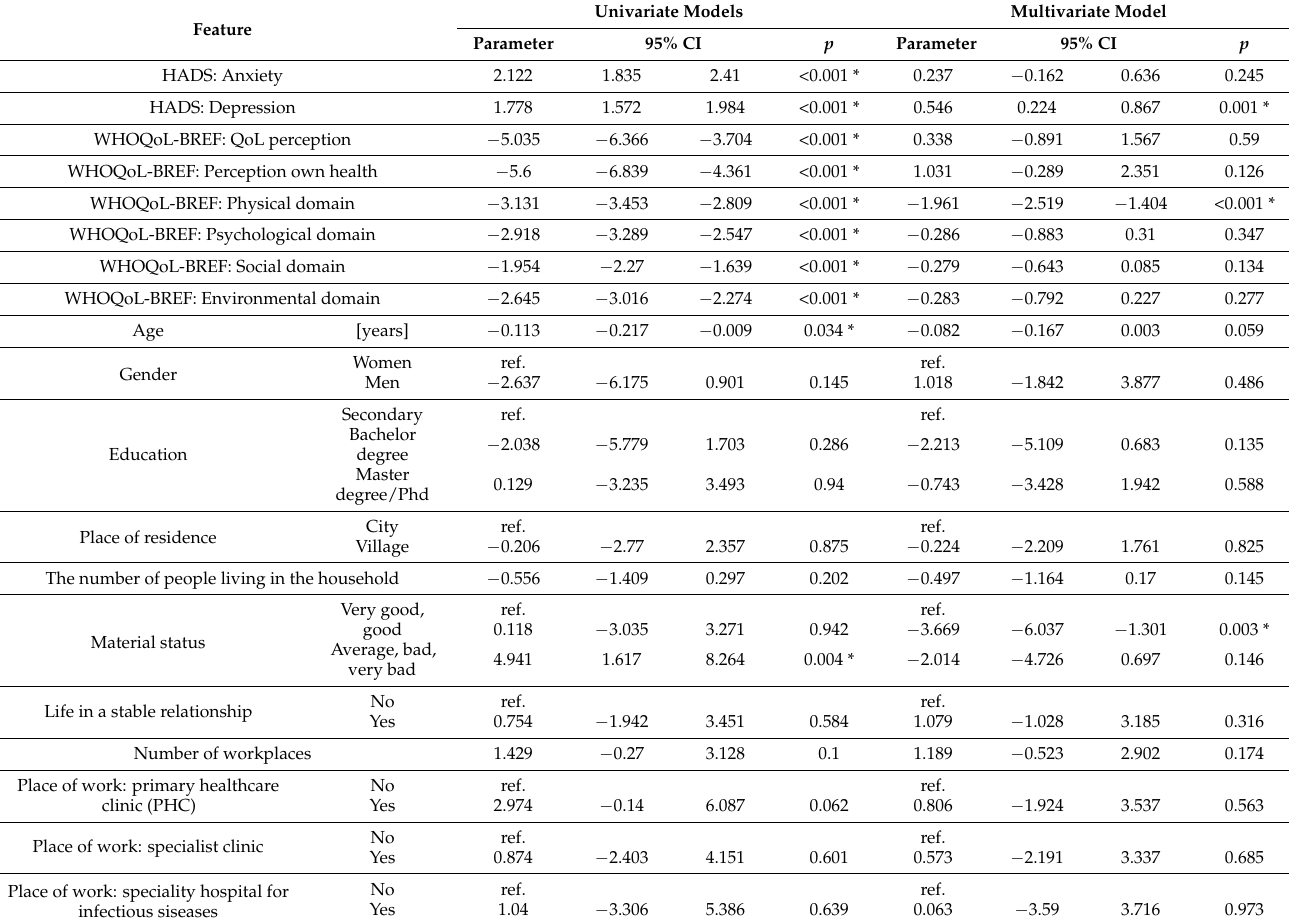
Table 4. Emotional exhaustion–mono- and multifactorial regression